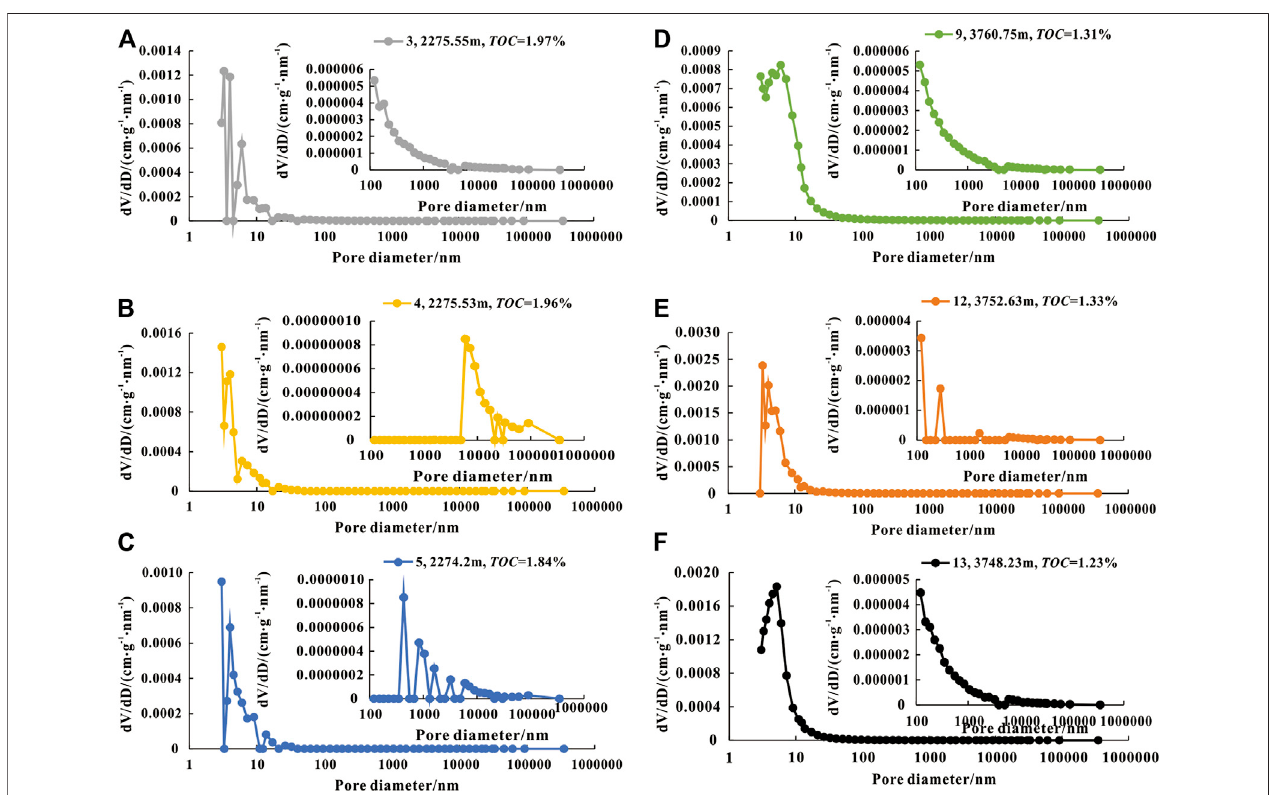
FIGURE 6 | Pore size distribution derived from MIP analysis. (A) Dongyuemiao Member sample no. 3; (B) Dongyuemiao Member sample no. 4; (C) Dongyuemiao Member sample no. 5; (D) Da ’ anzhai Member sample no. 9; (E) Da ’ anzhai Member sample no. 12; (F) Da ’ anzhai Member sample no. 13.